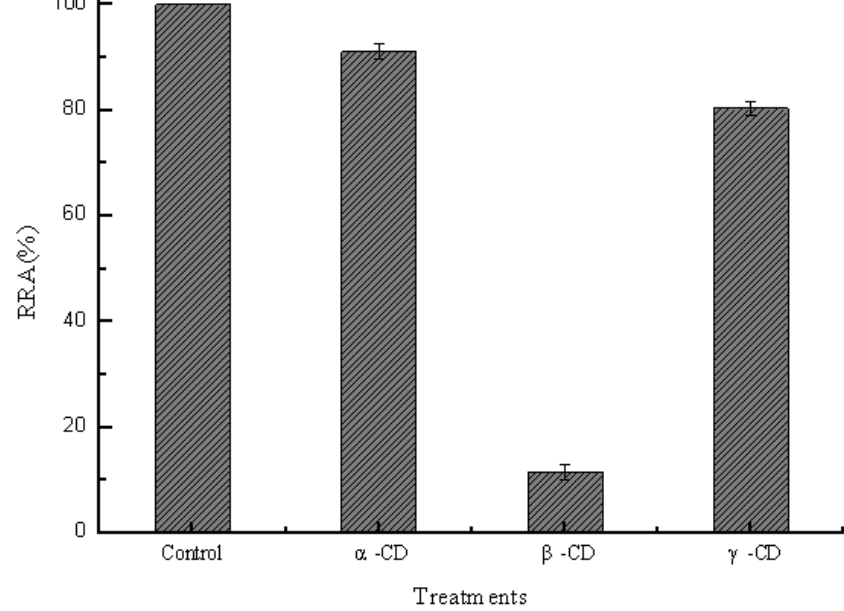
Figure 2. Effects of geometric dimension of hydrophobic cavities on the pullulanase